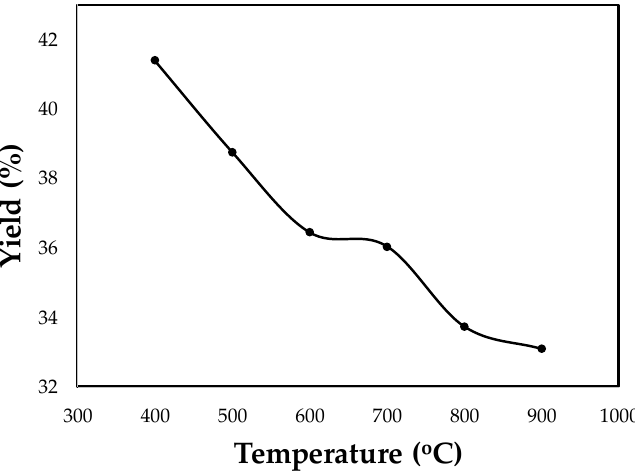
Figure 2. Variation in the yield of resulting RH-based biochar as a function of temperature.